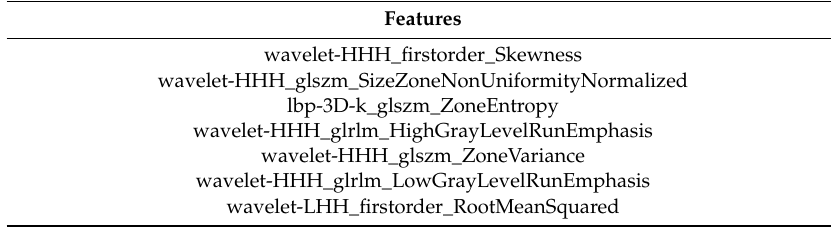
Table A1. List of features selected by recursive feature elimination for classification of pCR vs. non-pCR.